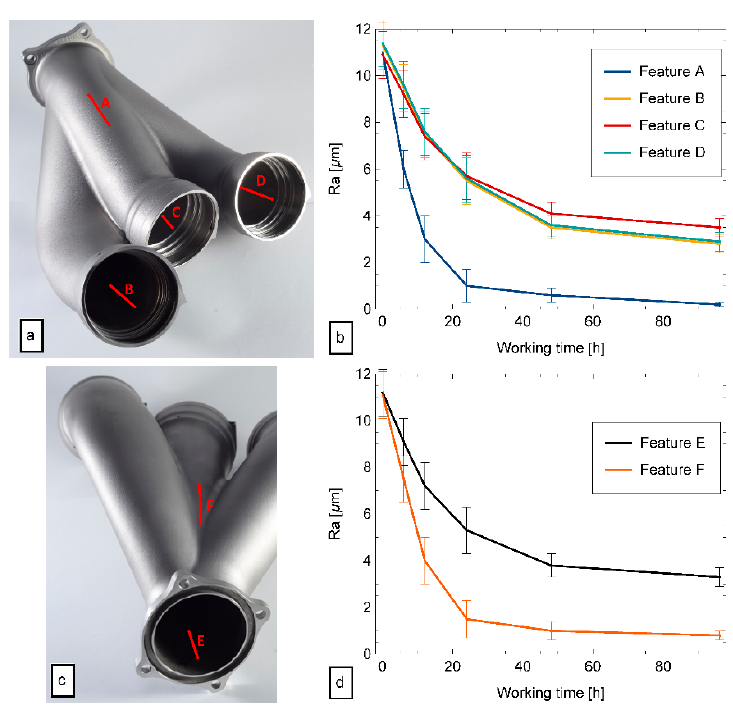
Figure 16. Investigated features ( a , c ) and average roughness trends as a function of BF working time ( b , d ).